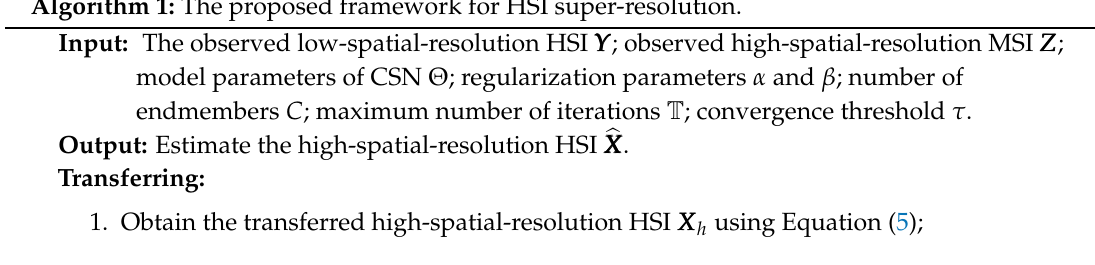
Algorithm 1: The proposed framework for HSI